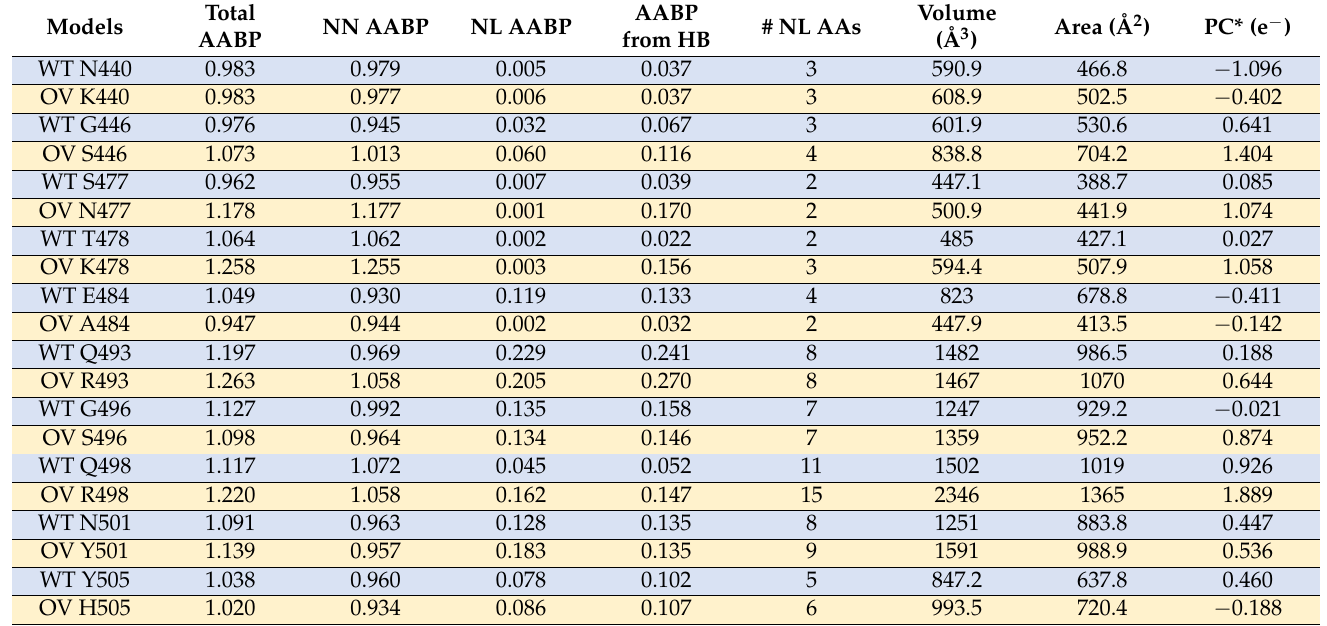
Table 1. Comparison of results between wild-type (WT) and Omicron variant (OV) for their amino acid–amino acid bond pair units (AABP units) in ten RBM sites. The two mutations in red have their volumes decreased after